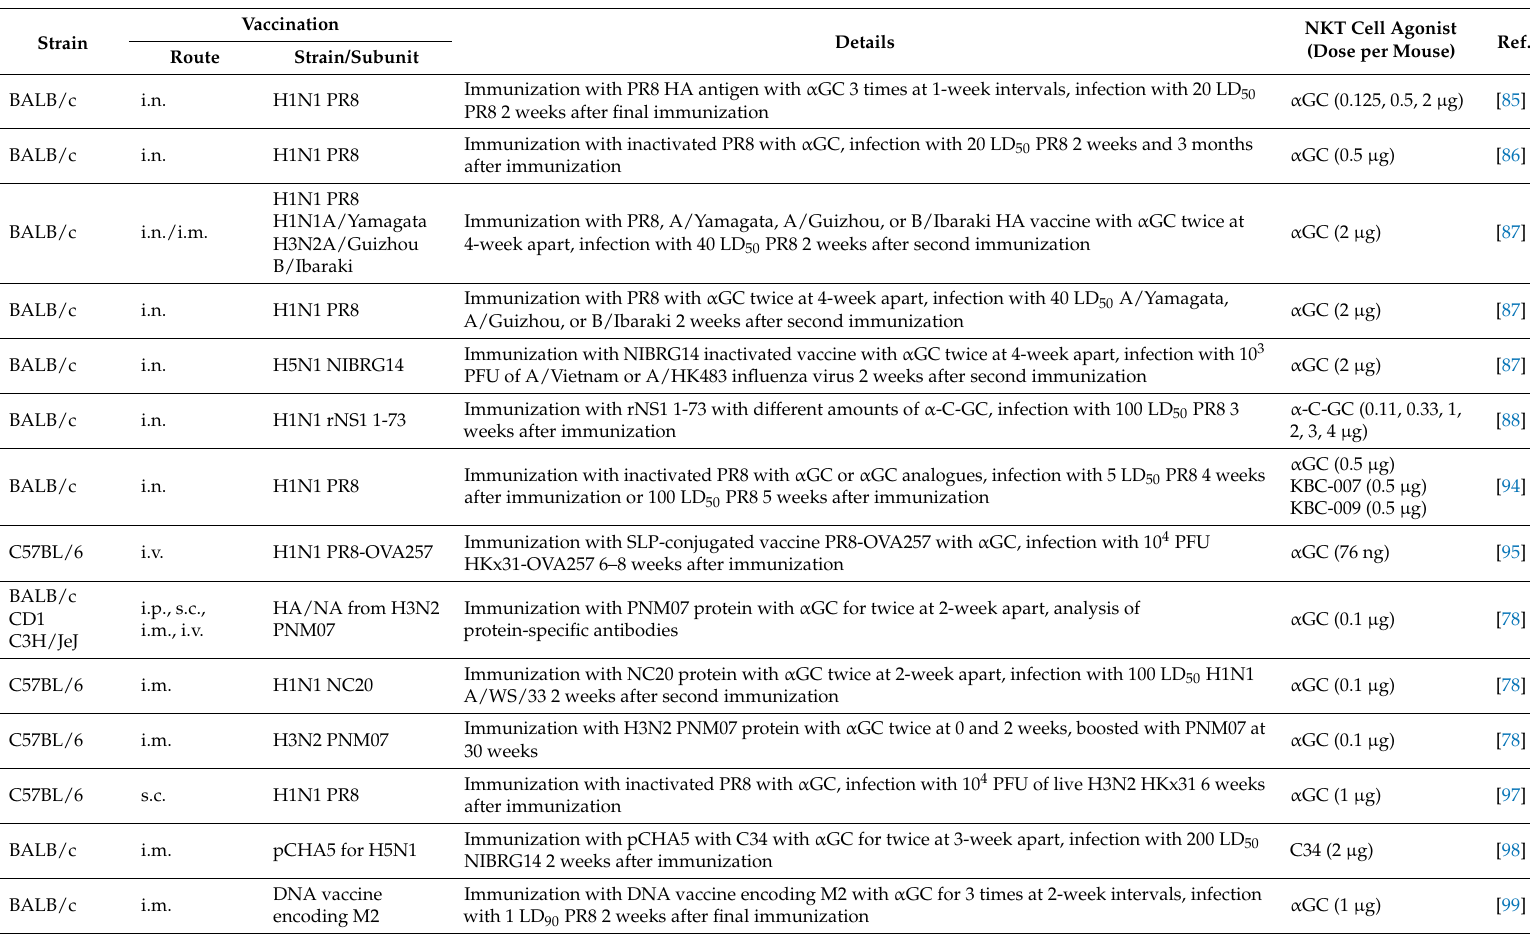
Table 1. Summary of murine studies using iNKT cell agonists as influenza vaccine